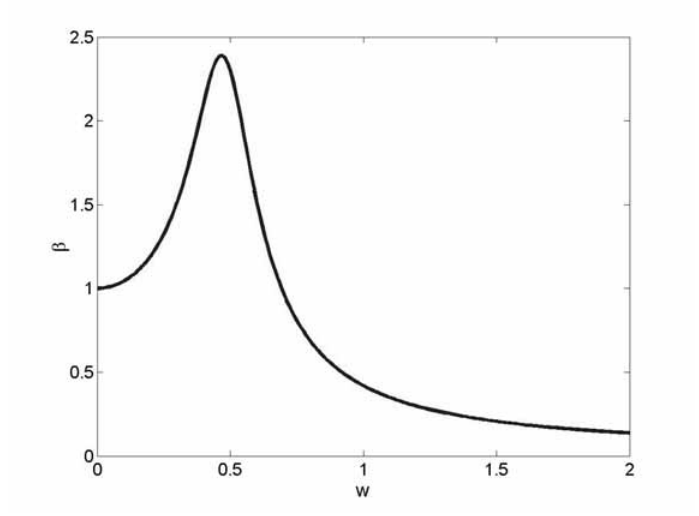
Fig. 5. Absolute engine mass displacement.